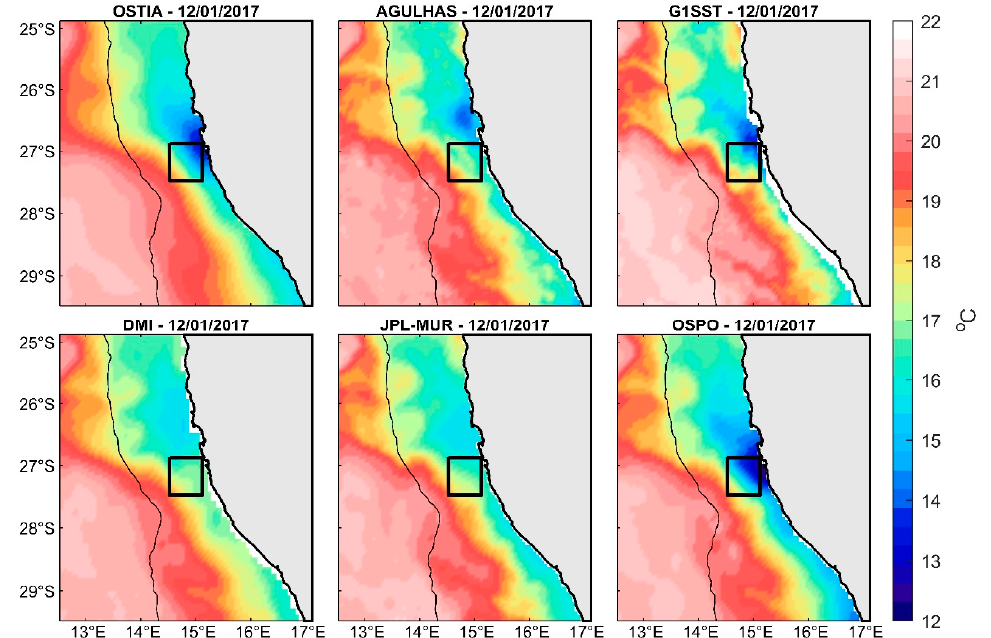
Figure 7. A daily snapshot for each L4, high resolution SST product for the 22 February 2017 in the southern Benguela. The thin black contour shows the 1000 m isobath. The black square shows the box referred to as the Cape Peninsula region, where the highest SST variance was observed.